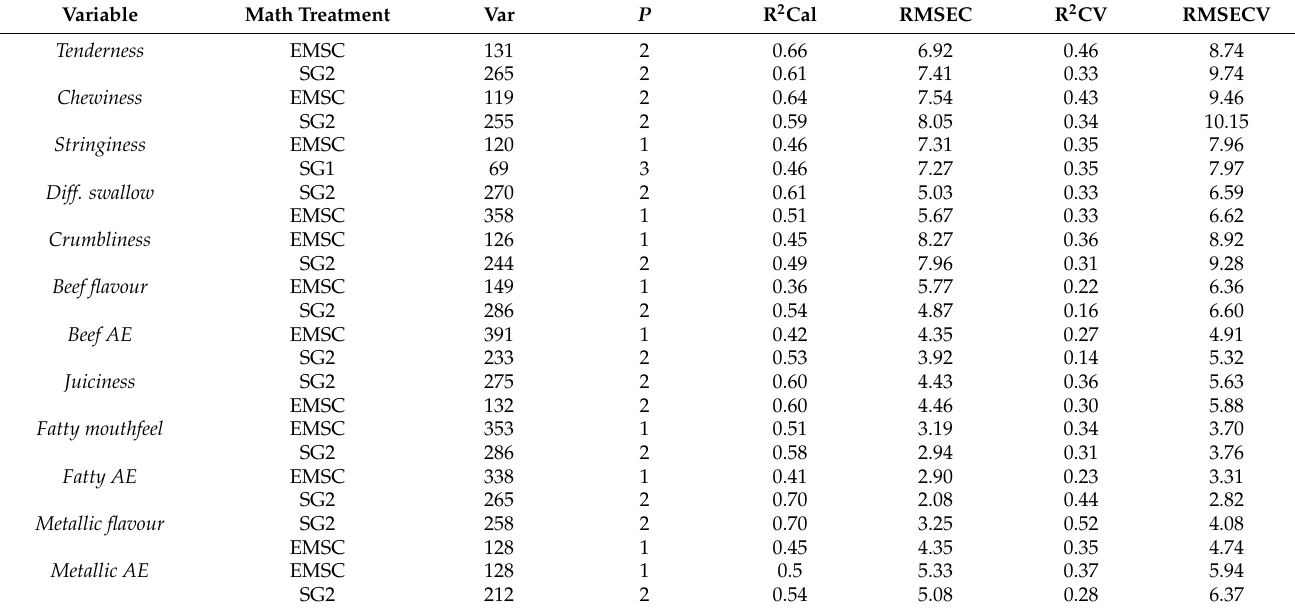
Table 2. Best fitting predictions of twelve sensory traits on beef LTL using Raman spectral